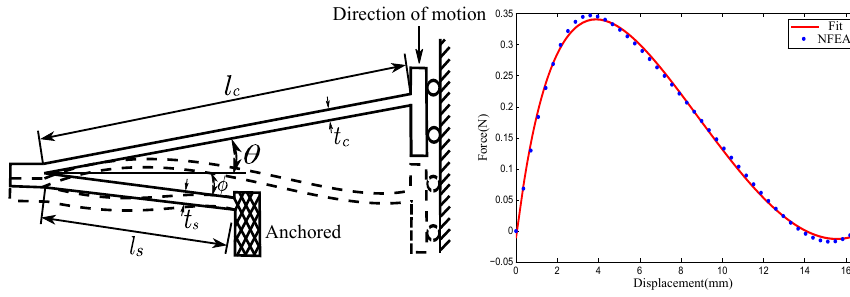
Figure 8. The structure of the fully compliant tensural bistable mechanism and its bistable kinetostatic behaviors. Table 3. Design parameters of the fully compliant tensural bistable mechanism (FTBM). H is the out-of-plane thickness of the mechanism, E is the Young’s modulus of